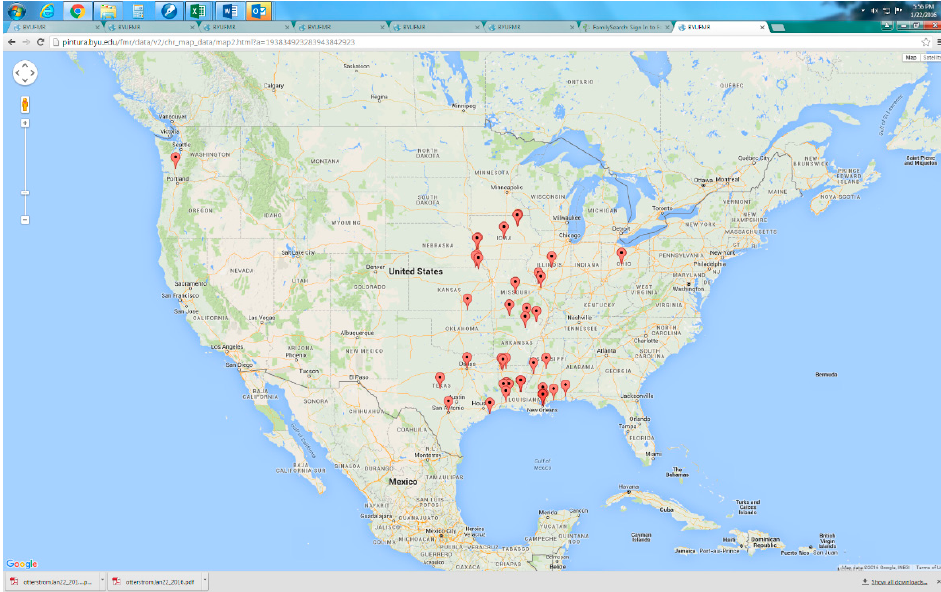
Figure 3. Birth locations of grandchildren of individuals born in New Orleans in 1850.